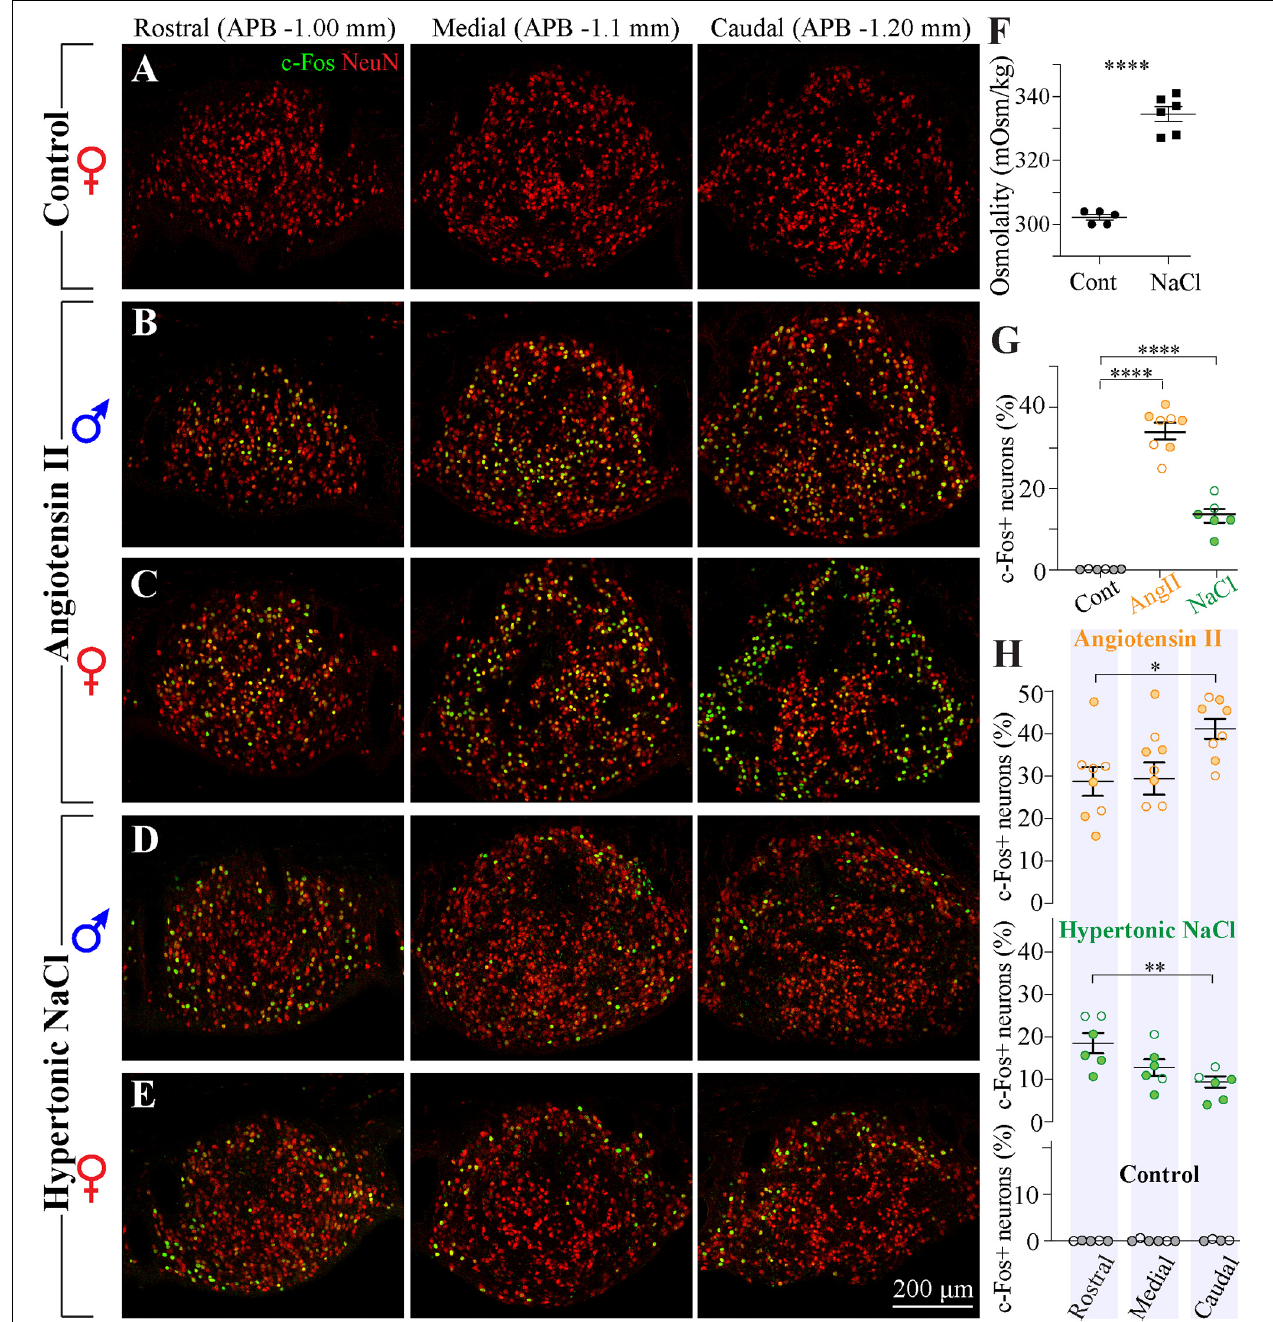
FIGURE 7 | Distribution of neurons responsive to Ang II and hypertonic NaCl stimulation in SFO from male and female rats. (A–E) Serial coronal sections representative of the rostral, medial, and caudal SFO regions (APB –1.0, –1.1, and –1.2 mm, respectively) immunolabeled for NeuN (red) and c-Fos (green). Brain sections were derived from rats sacrificed 1.5 h after injection of control isotonic saline [ (A) , female], 2 mg/ml Ang II [ (B) male, (C) female], or 1 M NaCl [ (D) male, (E) female]. (F) Plots show mean ± SEM blood osmolality 1.5 h following the injection of 1 M NaCl or isotonic saline. (G) Plots show mean ± SEM percentage of c-Fos positive neurons in different conditions. Each circle represents an average percentage determined by analysis of a rostral, a medial and a caudal SFO section from each rat [ n = 6 control (isotonic saline), n = 8 Ang II, n = 6 1 M NaCl]. (H) Distribution of c-Fos-positive neurons in the rostro-caudal axis of the SFO in response to injection of 2 mg/ml Ang II (top panel), 1 M NaCl (middle panel), and control isotonic saline (bottom panel). Plots show mean ± SEM percentage of c-Fos-positive neurons analyzed in rostral, medial and caudal regions (APB –1.0, –1.1, and –1.2 mm, respectively). Full circles represent the data from male and open circles from female rats. * p < 0.05, ** p < 0.01, and **** p < 0.0001.